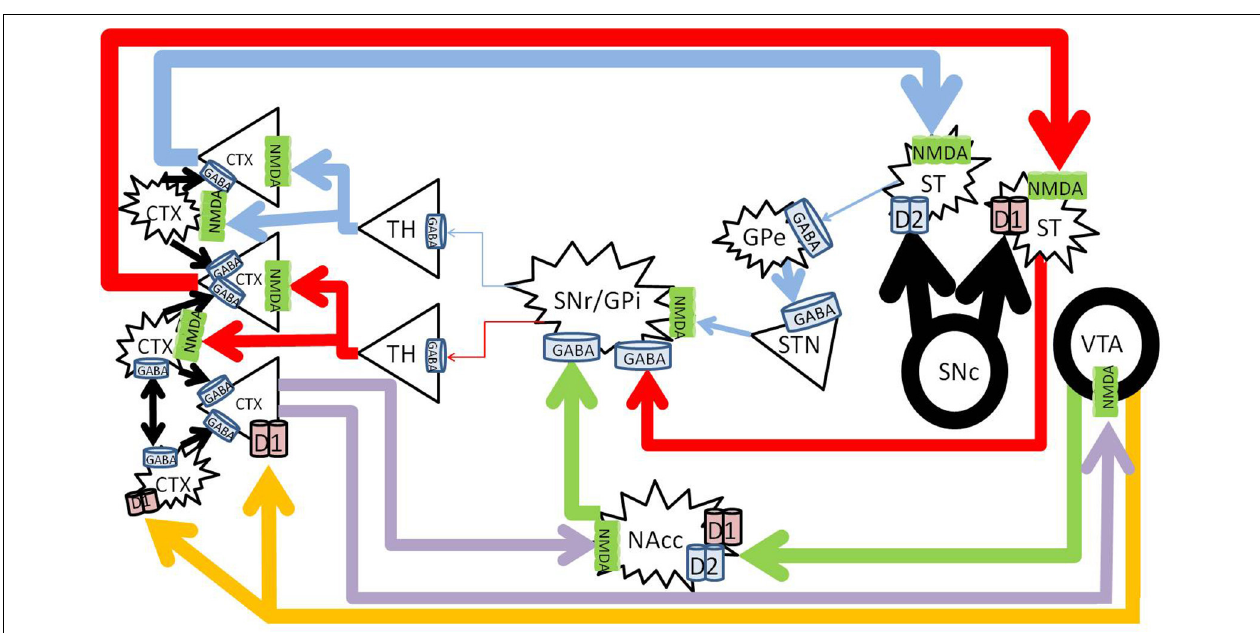
FIGURE 3 | Methamphetamine effects on dopaminergic pathways. Methamphetamine causes excessive amounts of dopamine to be released from the substantia nigra pars compacta (SNc) into the striatum (large black arrows), forcing pronounced inhibition of the SNr/GPi ( red and blue ). Dopamine from the VTA to the NAc increases NAc inhibition on the SNr/GPi ( green ). Enhanced cortical signals increases glutamate from the PFC to the NAc ( purple ) further increasing NAc inhibition on the SNr/GPi,